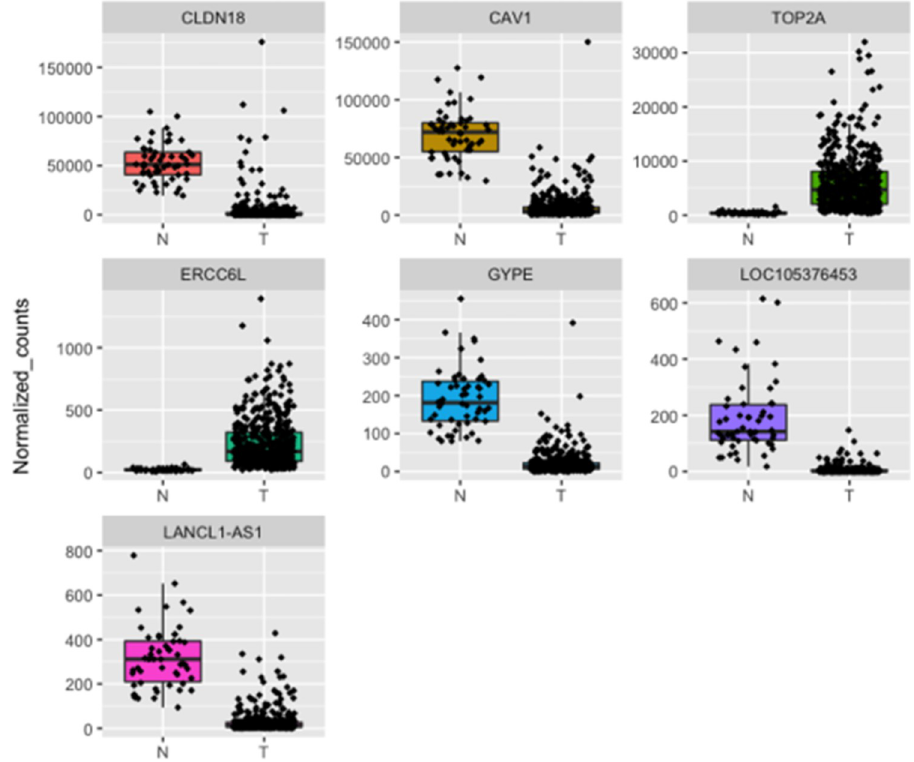
Fig 10. Boxplots representing the expression level of the MI-RF common genes in LUAD patients in comparison to normal samples. N represents normal tissues and T represents tumor tissues.